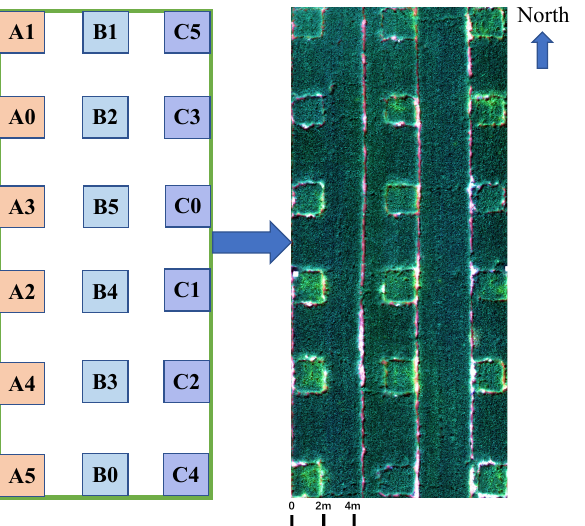
Figure 2. Wheat yellow rust disease inoculation: experiment design and visual layout with RGB